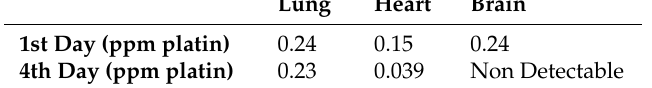
Table 1. Platin levels in 1 g of lung, heart and brain tissues.